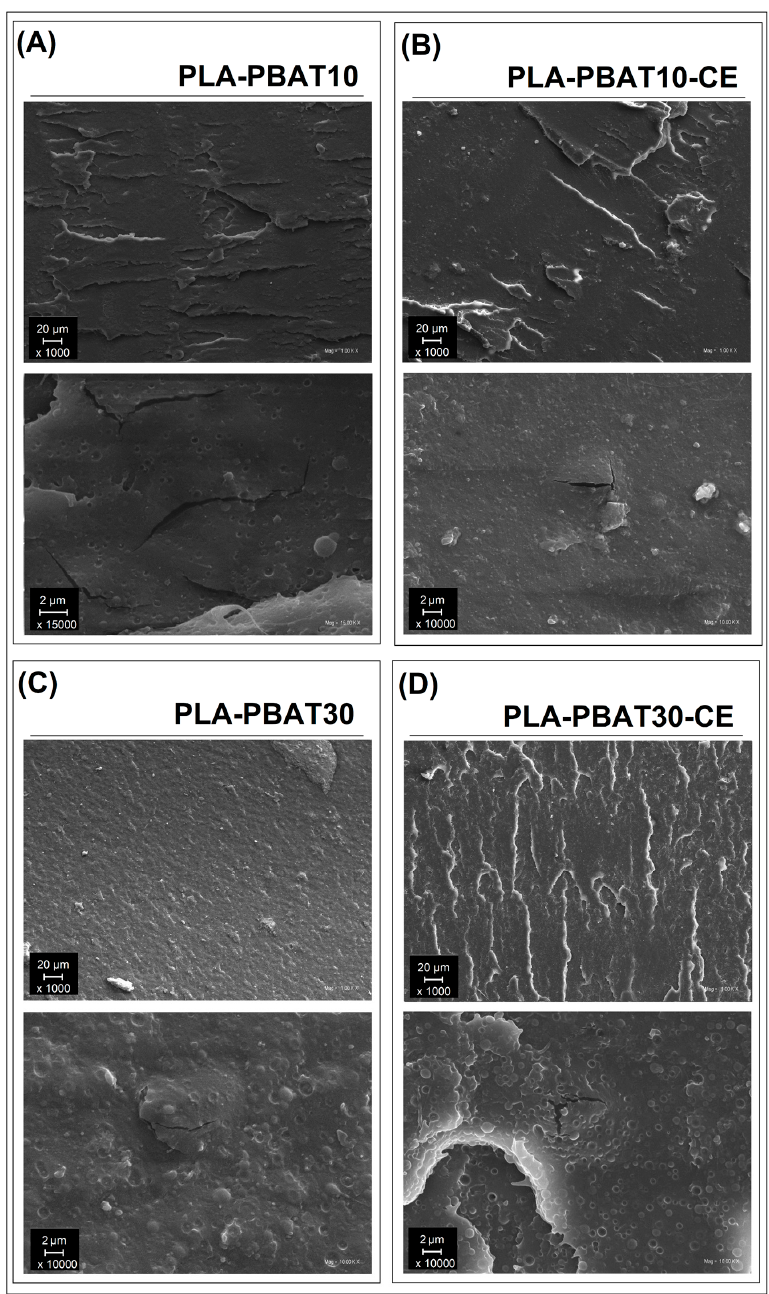
Figure 9. SEM picture presenting the fractured surface of the impact test specimens for samples containing 10% and 30% of the PBAT phase. ( A ) PLA-PBAT10, ( B ) PLA-PBAT10-CE, ( C ) PLA-PBAT30, ( D ) PLA-PBAT30-CE.